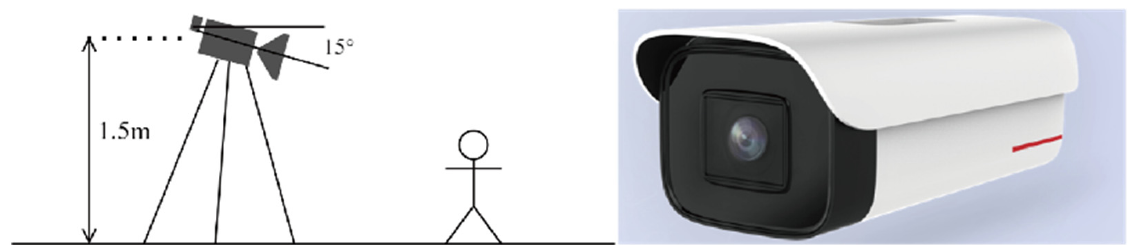
Figure 7. Schematic diagram of the video recording setup.